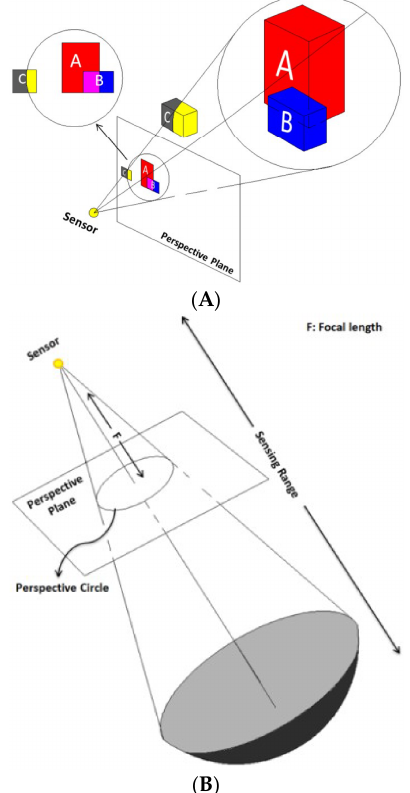
Figure 4. ( A ) Figuring polygons on perspective plate; and ( B ) perspective plate and perspective